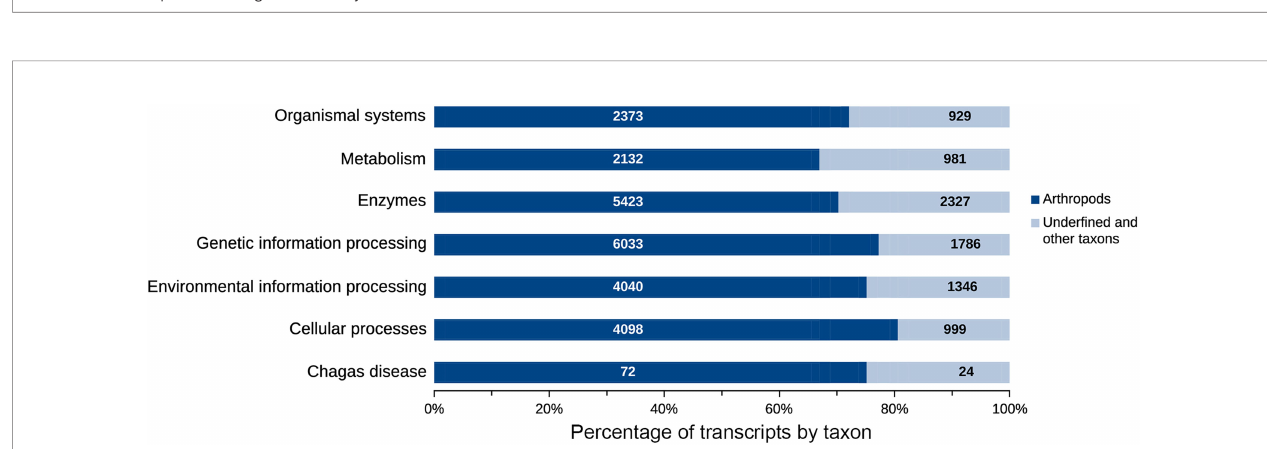
FIGURE 6 | Taxonomic annotation of transcripts according to the Kegg Orthology GhostKOALA database. (A) Total transcripts according to taxonomy. (B) Functionally annotated transcripts according to taxonomy.